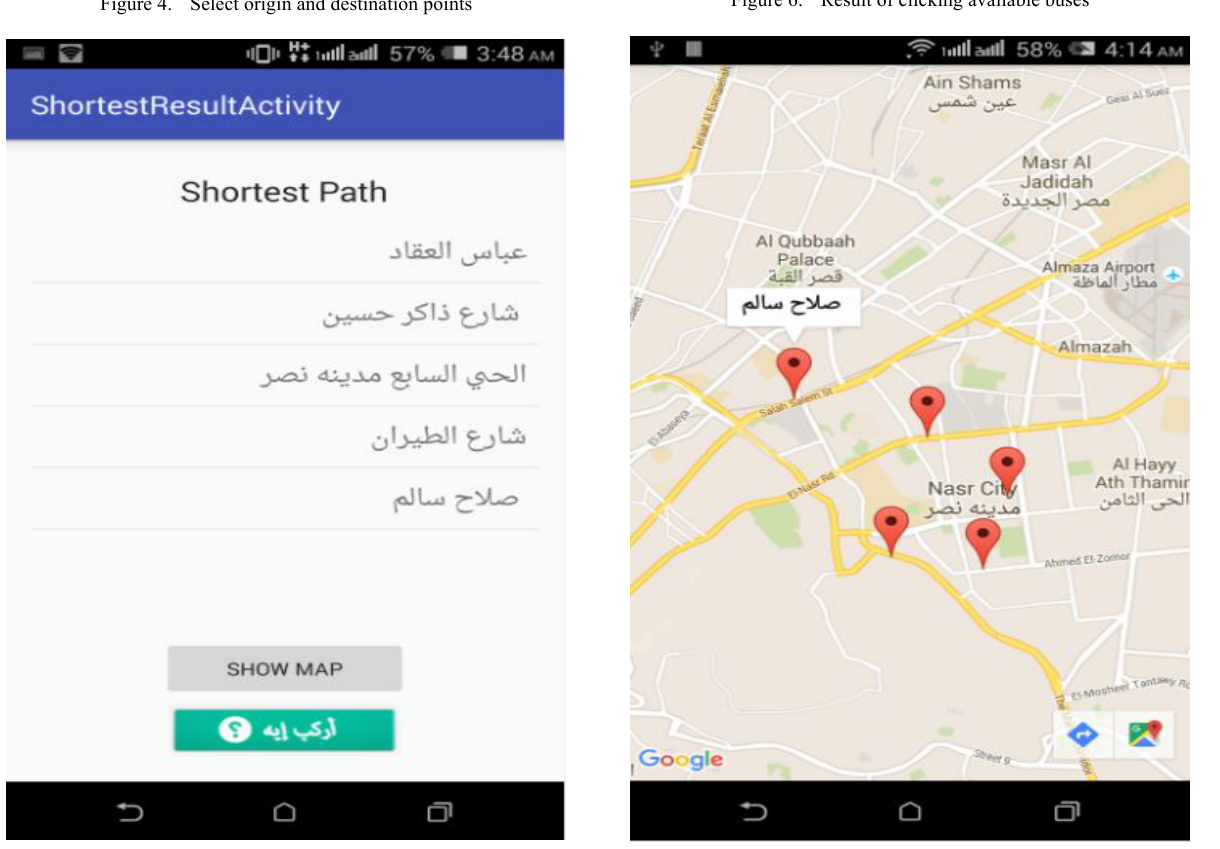
Figure 5. Shortest path resulting from the selection in Figure 4. Now Figure 7. Map displayed for the shortest route found (nodes the user has the choice of either finishing which bus to ride or to show a map of the route